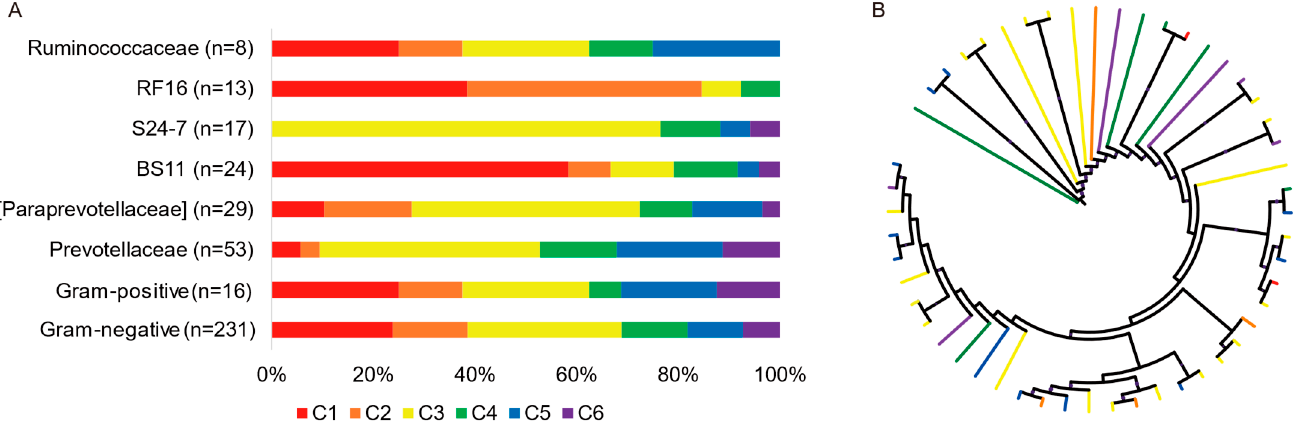
Figure 4. The proportion of the six temporal dynamic patterns in dominant families (average rela- tive abundance > 1%) and Gram-positive or negative bacteria ( A ). The phylogenetic tree of the treat- ment- and/or time-associated OTUs within the genus Prevotella ( B ).